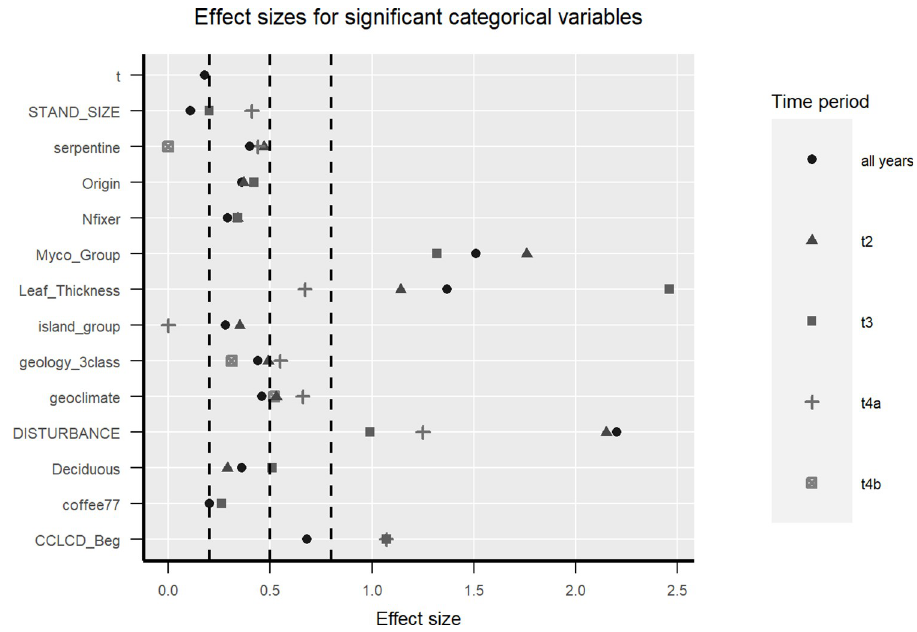
Fig 2. Univariate effect sizes for significant discrete variables. Class means for the data from all periods combined are shown in Fig 1 in S2 File. Dashed lines indicate categories of effect sizes. Effect sizes are considered small if < 0.2, medium if between 0.2 and 0.8, and large if >